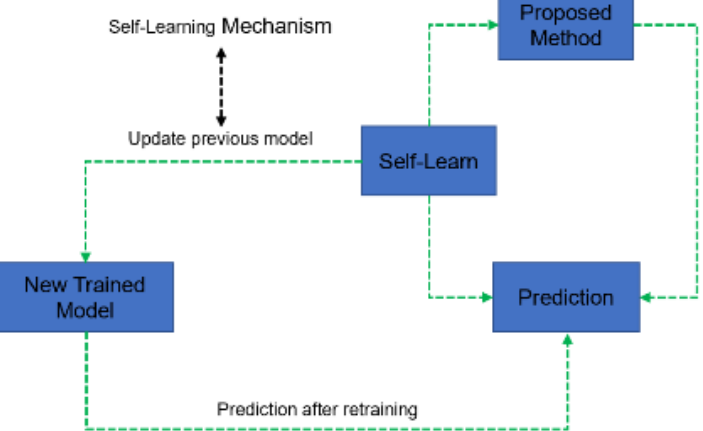
Figure 2. Self-training mechanism of the SVSL method.